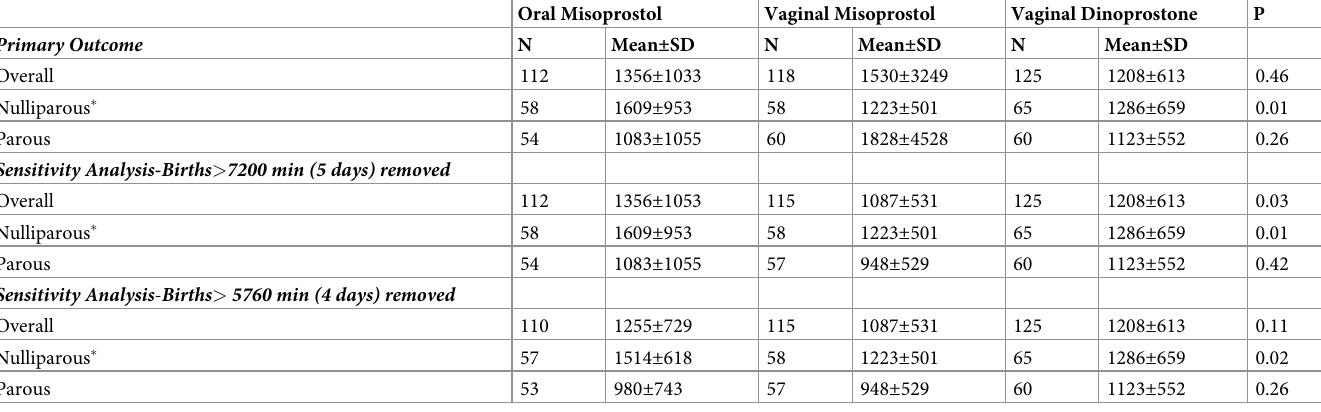
Table 4. Parametric analyses induction intervals to vaginal birth by parity (in minutes).